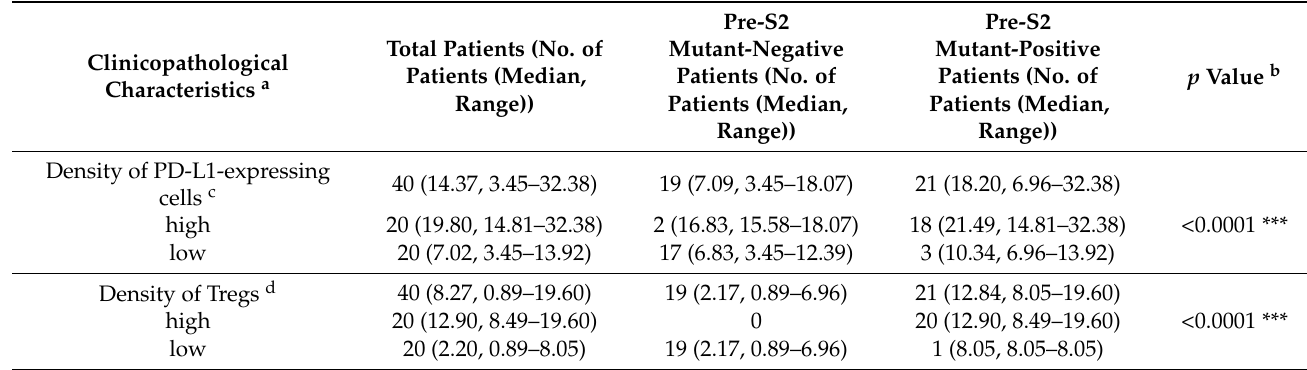
Table 2. Densities of PD-L1-expressing cells and Tregs in tumor tissues of the 40 HBV-related HCC